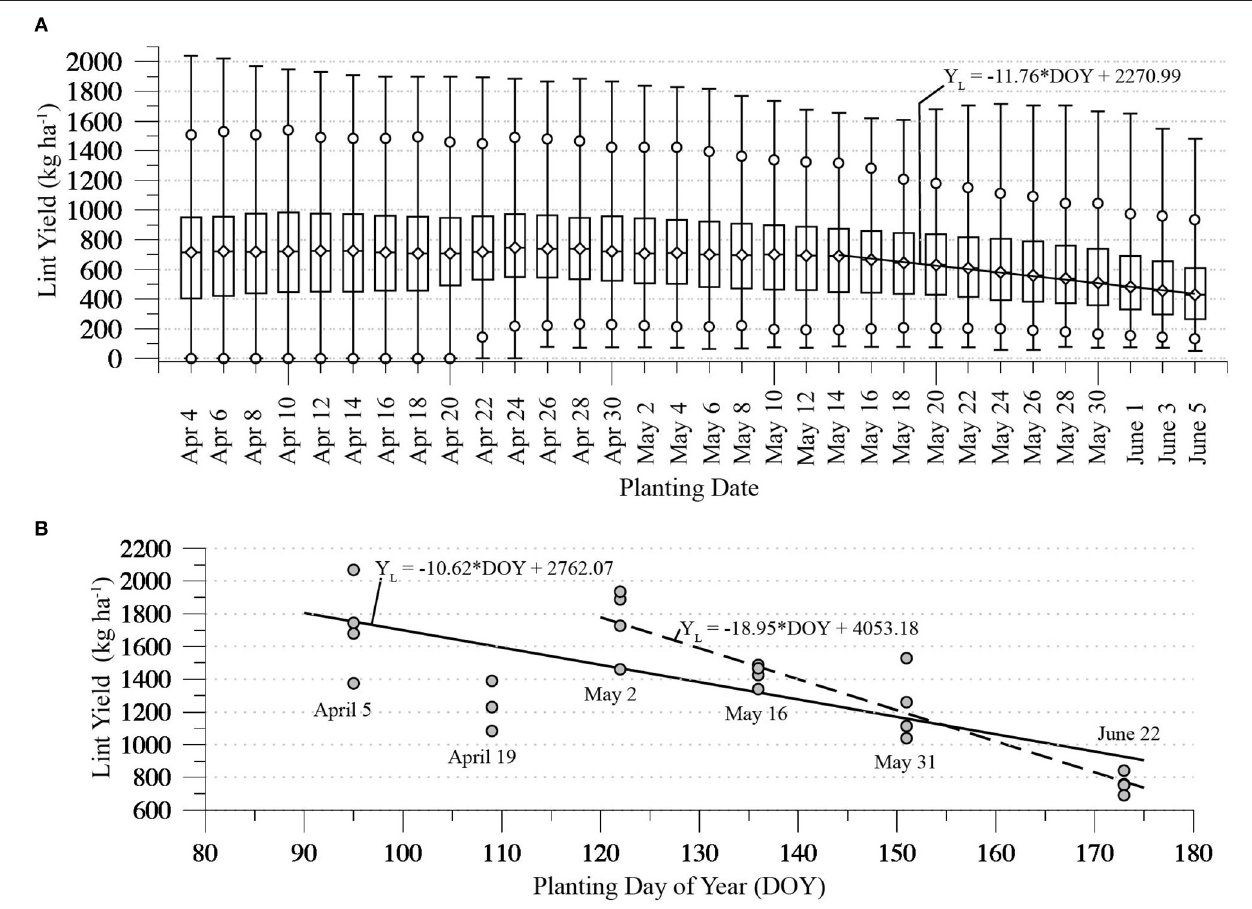
FIGURE 6 | (A) Percentiles of simulated lint yields for 3 plants met − 1 plant density and 0kg ha − 1 applied N, for planting dates between April 4 and June 5 at 2 day intervals. (B) Lint yields resulting from six planting dates during the PSWCL17 field trials. Dashed line plots linear fit to the May 2, 16, 31, and June 22 planted yields. Solid line plots a linear fit to the yields from all six